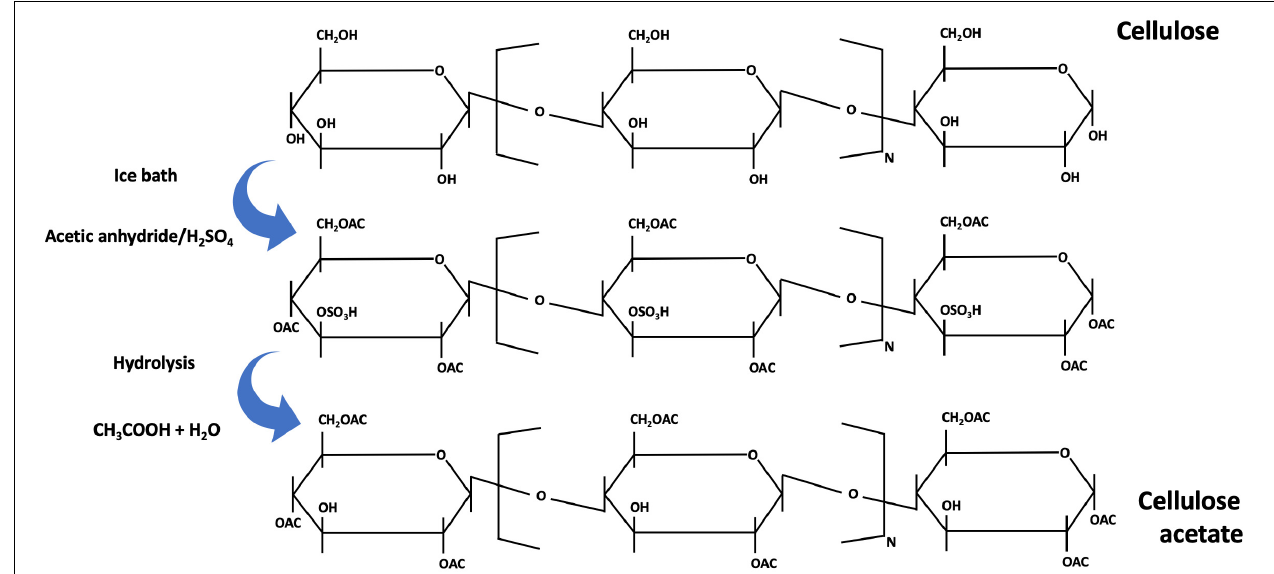
FIGURE 9 | Mechanism of the cellulose acetate preparation [addapted from Sayyed et al. (2019), Silva et al. (2017)].